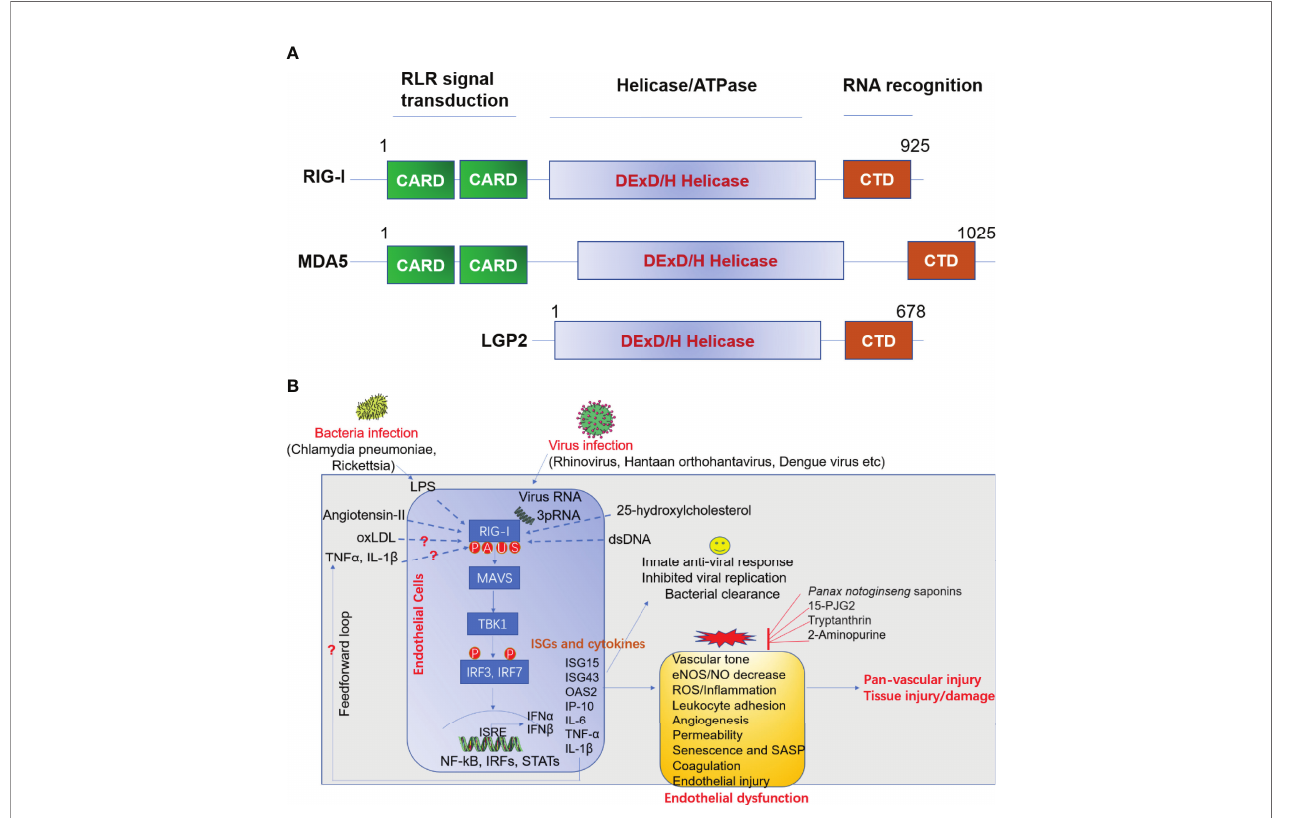
FIGURE 2 | (A) Domain structure of RIG-I like receptor (RLR). (B) Role of RIG-I in anti-viral response and endothelial dysfunction. LPS, lipopolysaccharide; oxLDL, oxidized LDL; TNF a , tumor necrosis factor a ; IL-1 b , interleukin 1 beta; RIG-I, retinoic acid-inducible gene I; MAVS, mitochondrial antiviral signaling; TBK1, TANK- binding kinase 1; IRF, interferon response factor; ISRE, interferon-sensitive responsive element; NF- k B, nuclear factor kappa B; STAT, signal transducer and activator of transcription; ISG, interferon-stimulated gene; IL-6, interleukin-6; IP-10 (also known as CXCL10), Interferon gamma-induced protein 10; eNOS, endothelial nitric oxide synthase; NO, nitric oxide; 15-dPGJ2, 15-deoxy-delta-12,14-prostaglandin J2; ROS, reactive oxygen species; SASP, senescence-associated secretory phenotype; IFN, interferon; OAS2, 2 ’ -5 ’ -oligoadenylate synthetase 2; MDA5, melanoma differentiation-associated protein 5; LGP2, laboratory of genetics and physiology 2; CARD, caspase activation and recruitment domains; CTD, c-terminal domain. A, acetylation; P, phosphorylation; U, ubiquitination; S,